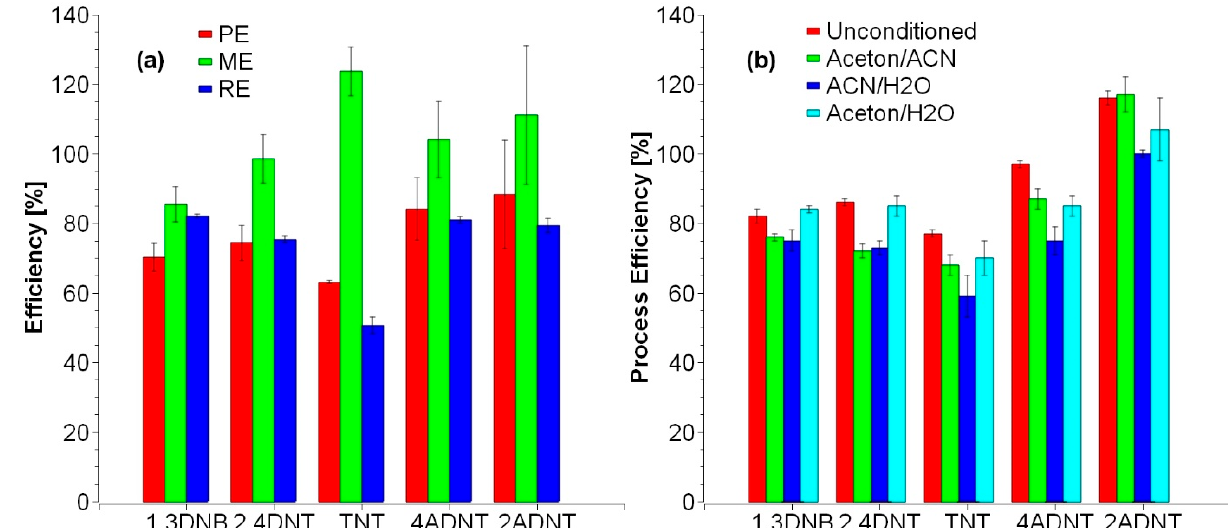
Figure 3. ( a ) Process efficiency (PE; n = 6), matrix effect (ME; n = 6), and recovery efficiency (RE, n = 2) of 10 ng of the mentioned explosives by SPE-Extraction with unconditioned Chromabond Easy columns. ( b ) Process efficiency of different column conditions. No major advantages were found compared to the unconditioned ones.